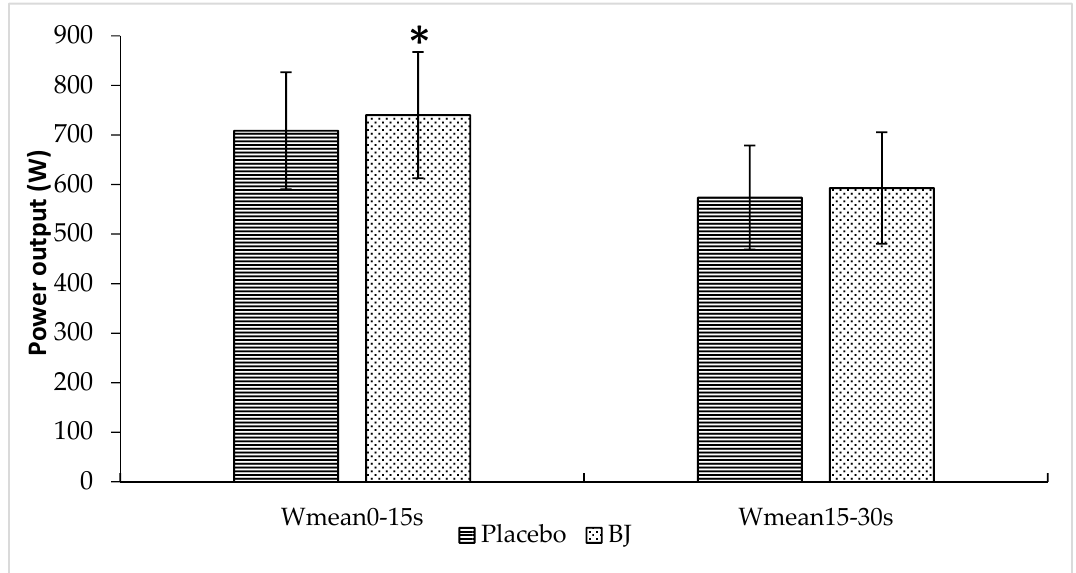
Figure 3. Effects of placebo and BJ intake on W mean values recorded over 15 s intervals (A, W 0–15s ; B, W 15–30s ) after the sprint. * p < 0.05 compared to placebo.